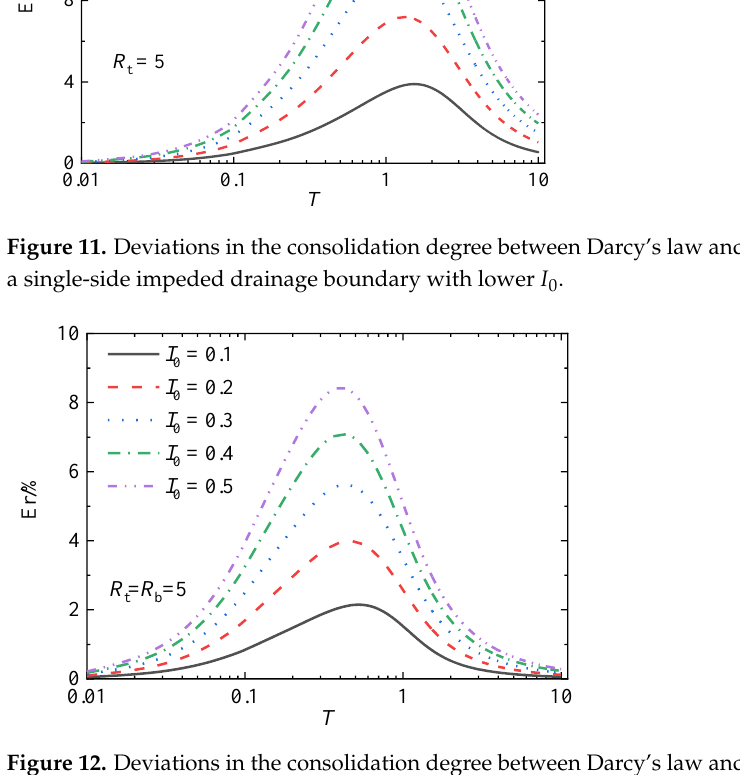
Figure 12. Deviations in the consolidation degree between Darcy’s law and non-Darcian flow under a double-side impeded drainage boundary with lower I 0 .